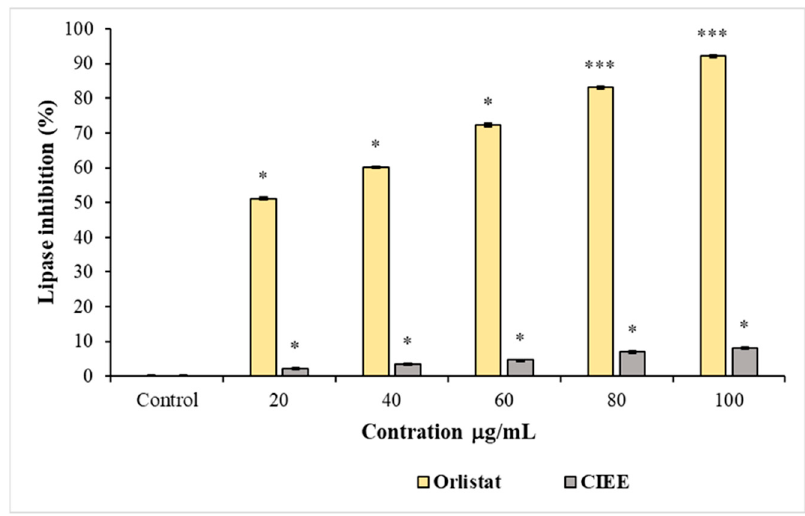
Figure 6. The effect of ethanolic extract of C. incana on pancreatic lipase activity. CIEE: Calamintha incana ethanolic extract, Orlistat: positive control. Data presented as the mean ± SD (N = 3). * p < 0.05, *** p < 0.001 vs. untreated enzyme (control) (ANOVA, Tukey’s post hoc test).